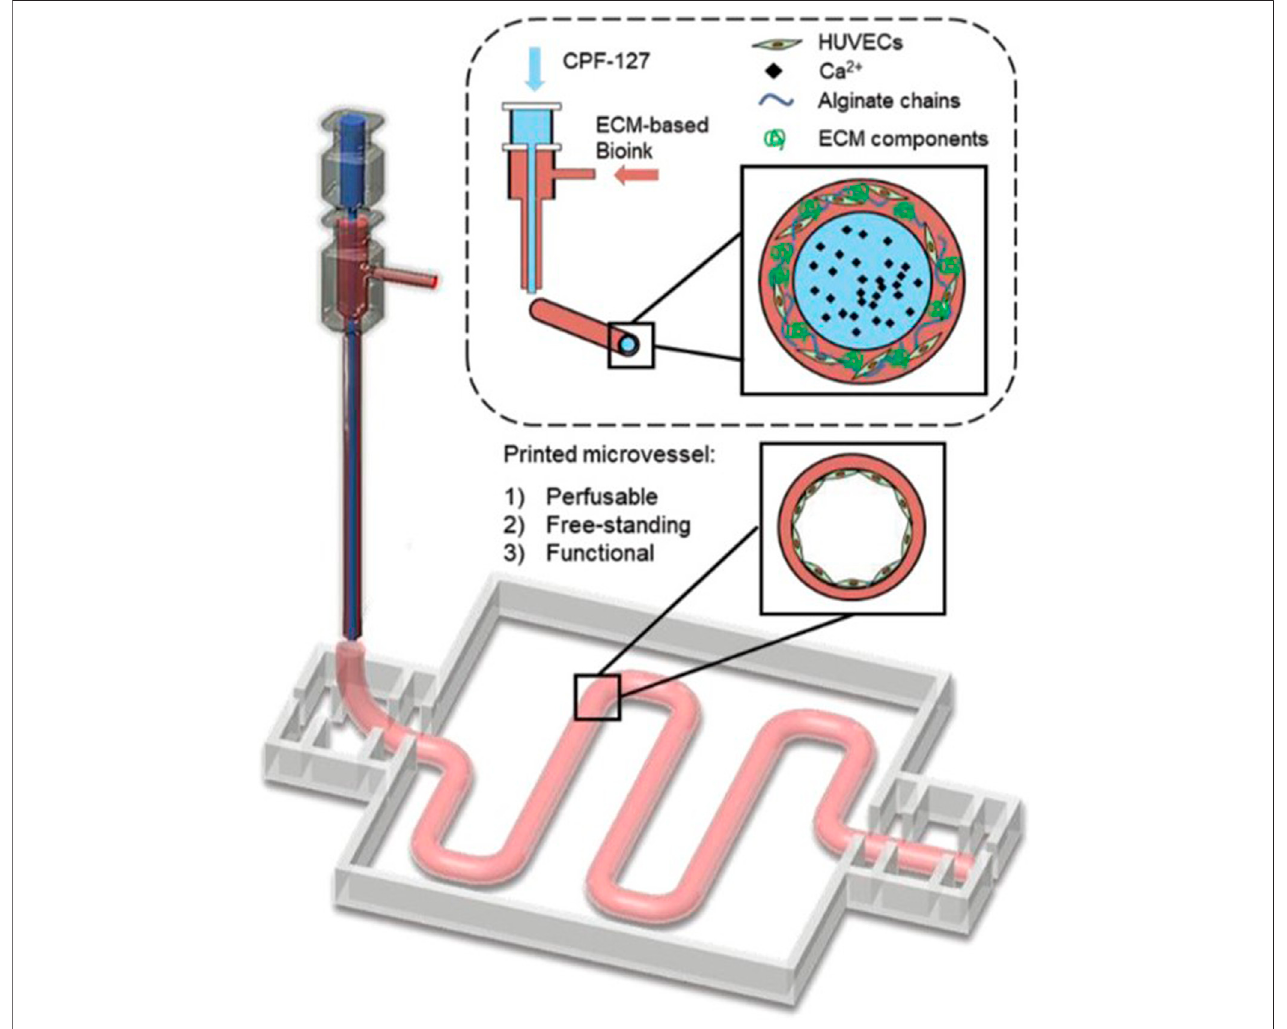
FIGURE6 | 3D bioprinting ofvasculature using core-shellapproach, where endothelialcells are suspended inan alginate-ECMbioinkasthe shell and thecore isa fugitive bioink composed of Pluronic F127 containing Ca 2+ ions (CPF127) [modi fi ed from (Gao et al., 2018)].